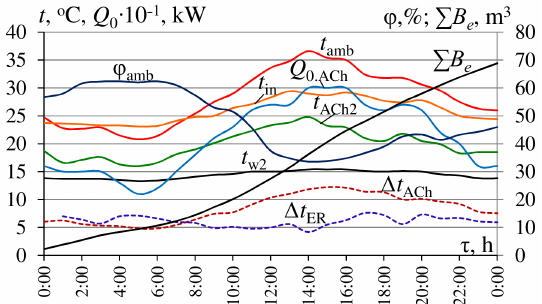
Figure 4. Daily variations in temperature t amb and relative humidity ϕ amb of ambient air, temperature of air at the gas engine inlet t in , and at the high-temperature air cooler outlet t ACh2 = t HT , ∆ t ACh = ∆ t ∆ t − t − t HT = t amb HT ; ER = t in HT